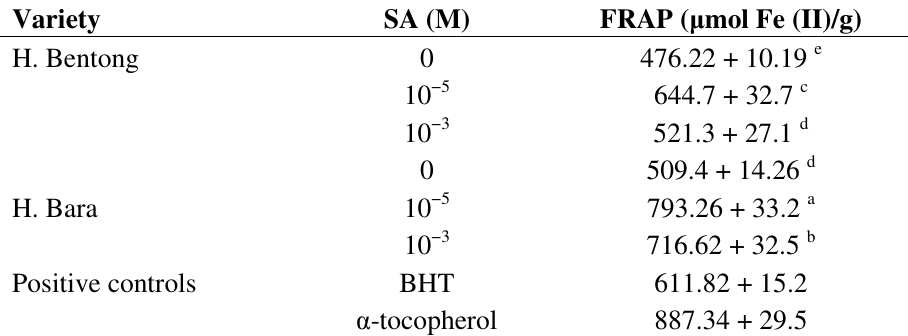
Table 2. Antioxidant activity (FRAP) in two varieties of Zingiber officinale treated with different concentration of salicylic acid